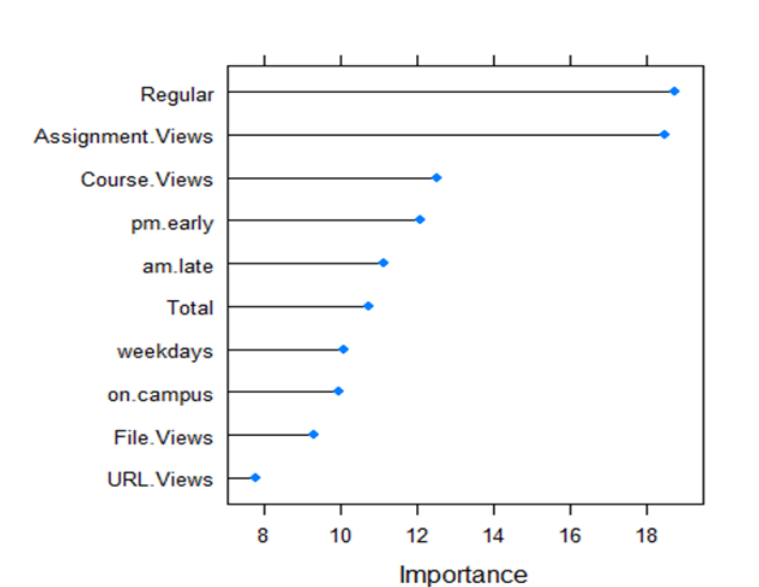
Figure 5: Variable Importance in Random Forest (Pass/Fail -10 Week